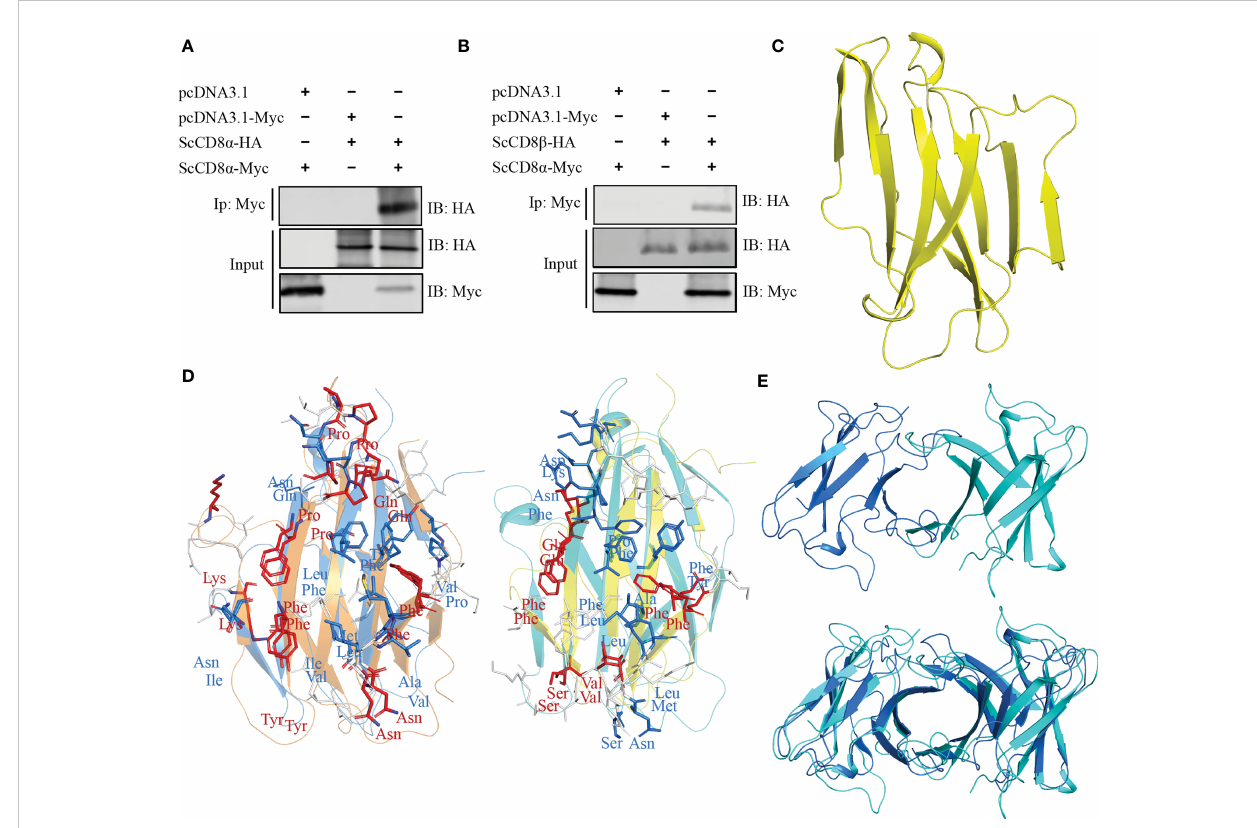
FIGURE 6 Interaction and modelling and of Sc CD8 a and Sc CD8 b . (A, B) Interaction of Sc CD8 a with Sc CD8 a (A) and Sc CD8 b (B) . HEK293 cells were co- transfected with the indicated expression plasmids (5 m g each). After 24h, cell lysates were immunoprecipitated (IP) with a -Myc Ab conjugated agarose beads, and immunoblotted (IB) was detected with a -Myc or a -HA Abs. (C) Model of Sc CD8 b shown as a cartoon structure. (D) Predicted interface of CD8 ab with the Sc CD8 a monomer shown in marine, Sc CD8 b in cyan, mouse CD8 a in orange, and CD8 b in yellow. The side chains of key residues forming the CD8 ab interface are shown as sticks. Conserved residues are colored red, physiochemically-conserved residues are colored marine, other residues are shown in white. (E) The structural model of Sc CD8 ab (top) and shown structurally aligned with Sc CD8 aa (bottom). Sc CD8 a is colored marine and Sc CD8 b